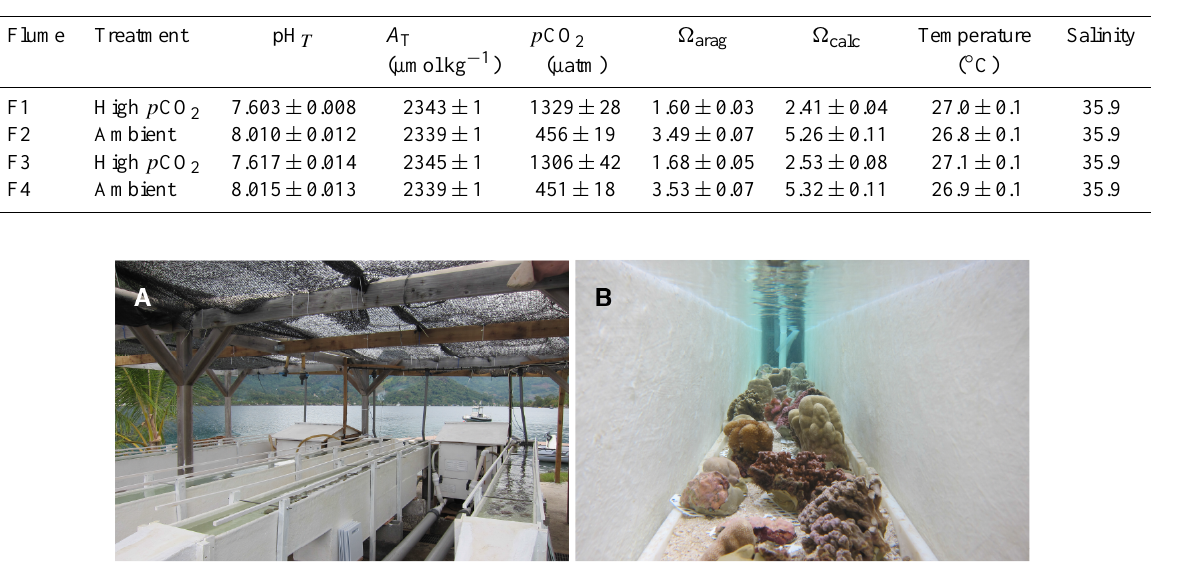
Table 1. Mean carbonate chemistry in the four flumes (F1–4) during the 8-week incubation. The partial pressure of CO 2 ( p CO 2 ) , the aragonite saturation state ( (cid:127) arag ) , and the calcite saturation state ( (cid:127) calc ) were calculated from pH T , total alkalinity ( A T ) , temperature, and salinity. The values presented are mean ± SE ( n = 56). SE for salinity was <0.1.